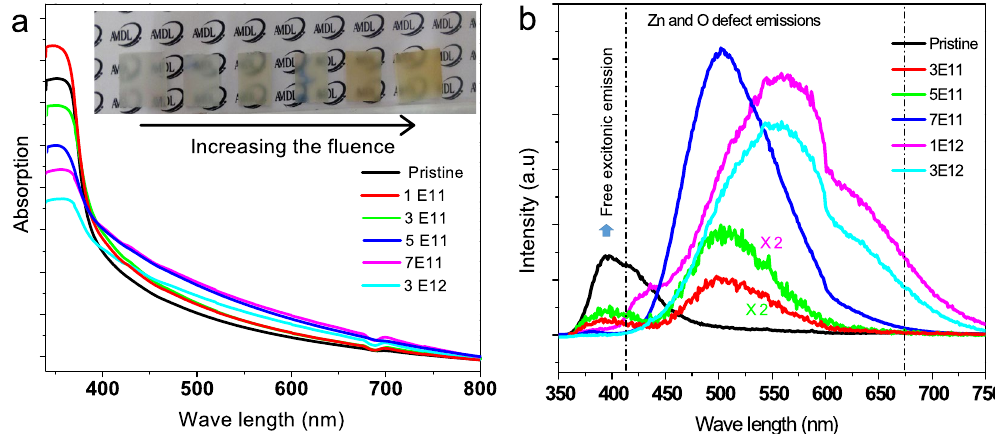
Figure 5. ( a ) Optical absorption spectra denoting band edge shift towards larger wavelength with increasing ion fluences. The photograph of the ZnO NR arrays exhibits changes in colour corresponding to increase in ion fluences ( b ) PL spectra of ZnO nanorods irradiated under different ion fluences. The PL emission defect intensity enhanced with ionic fluence, suggesting the enhancement of the oxygen defects in ZnO NRs. There is an appearance of emission peak at yellowish region above the ion fluence of 7E11 ions/cm 2 indicating the creation of oxygen interstitials.